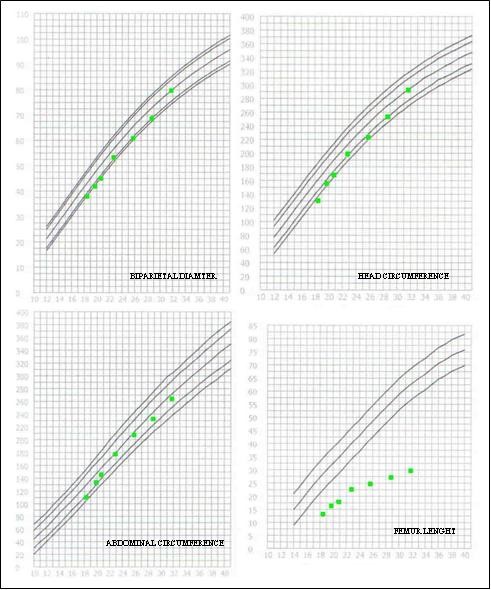
Fetal auxological measurements showing the shortening of the femur beginning with the 15th the week of gestation.